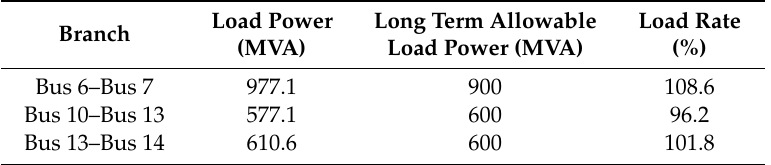
Table 3. Statistical Table of Overloaded Components Under an N-1 Contingency.